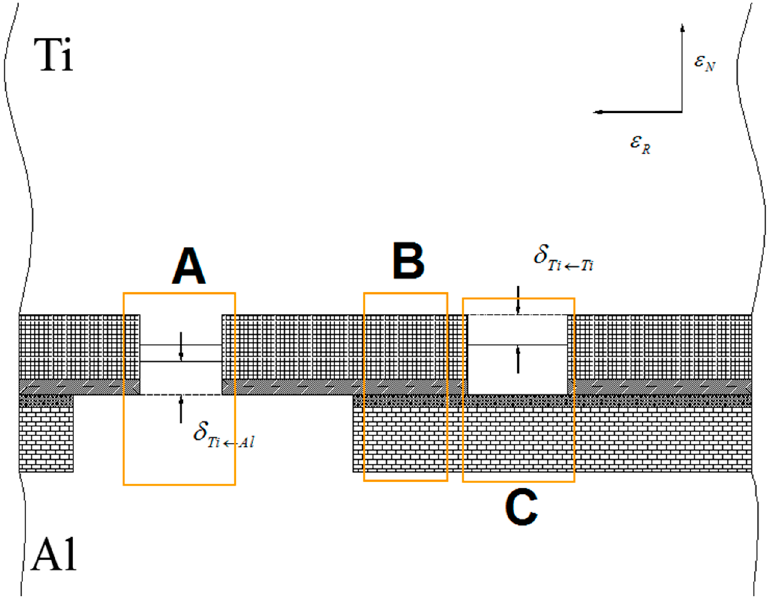
Figure 30. Extrusion flow of aluminium and titanium in cracks of WHL on the surface of the titanium layer.